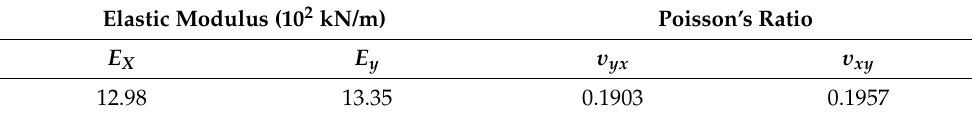
Table 2. Elastic constants of biaxial tension based on the least square